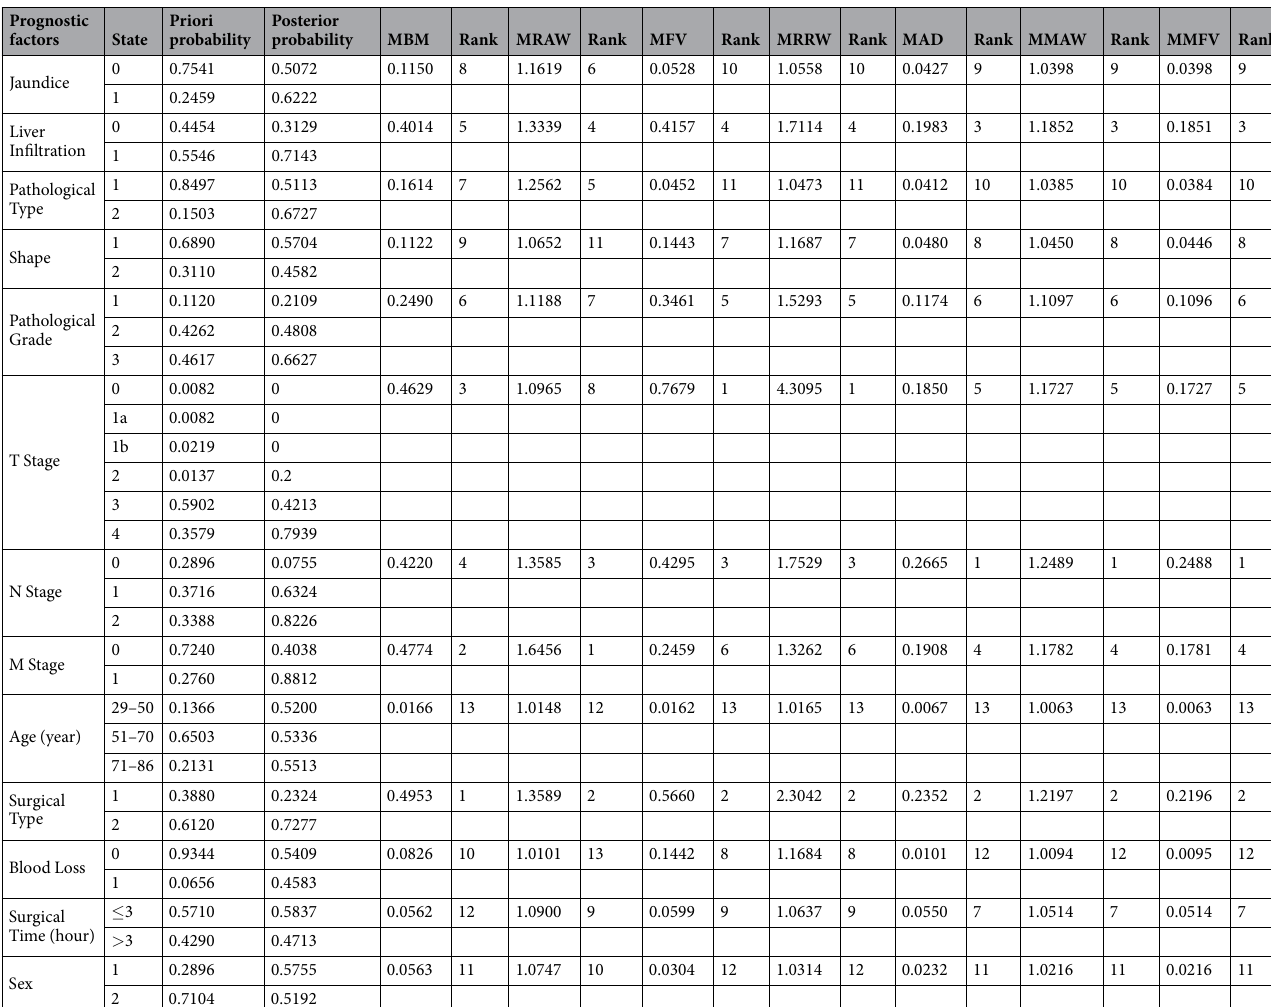
Table 3. Importance of prognostic factors in survival time ranking.